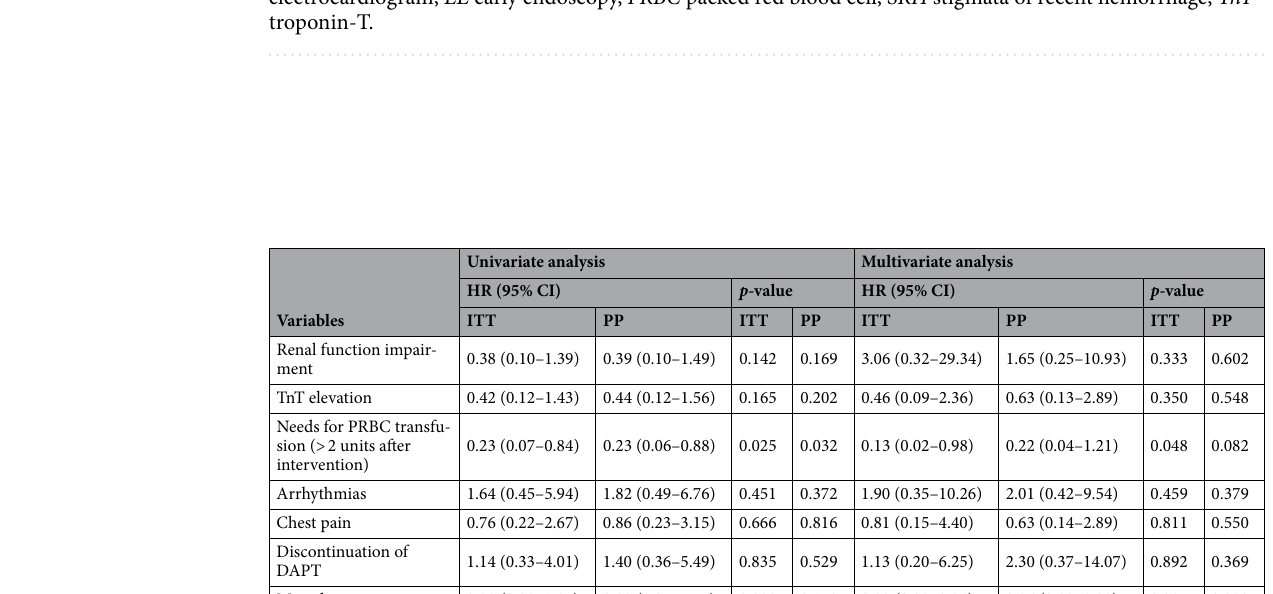
Table 2. Efficacy and safety of early endoscopy versus medical therapy alone for management of acute upper gastrointestinal bleeding in acute coronary syndrome patients. CK‑MB creatine kinase-MB, ECG